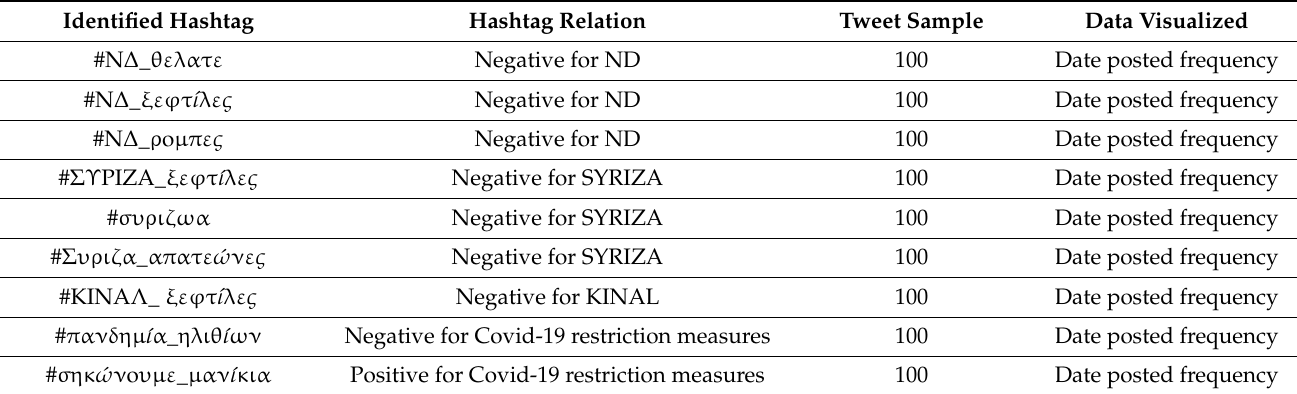
Table 4. Identified negative hashtags per political party and negative/positive hashtags for covid-19